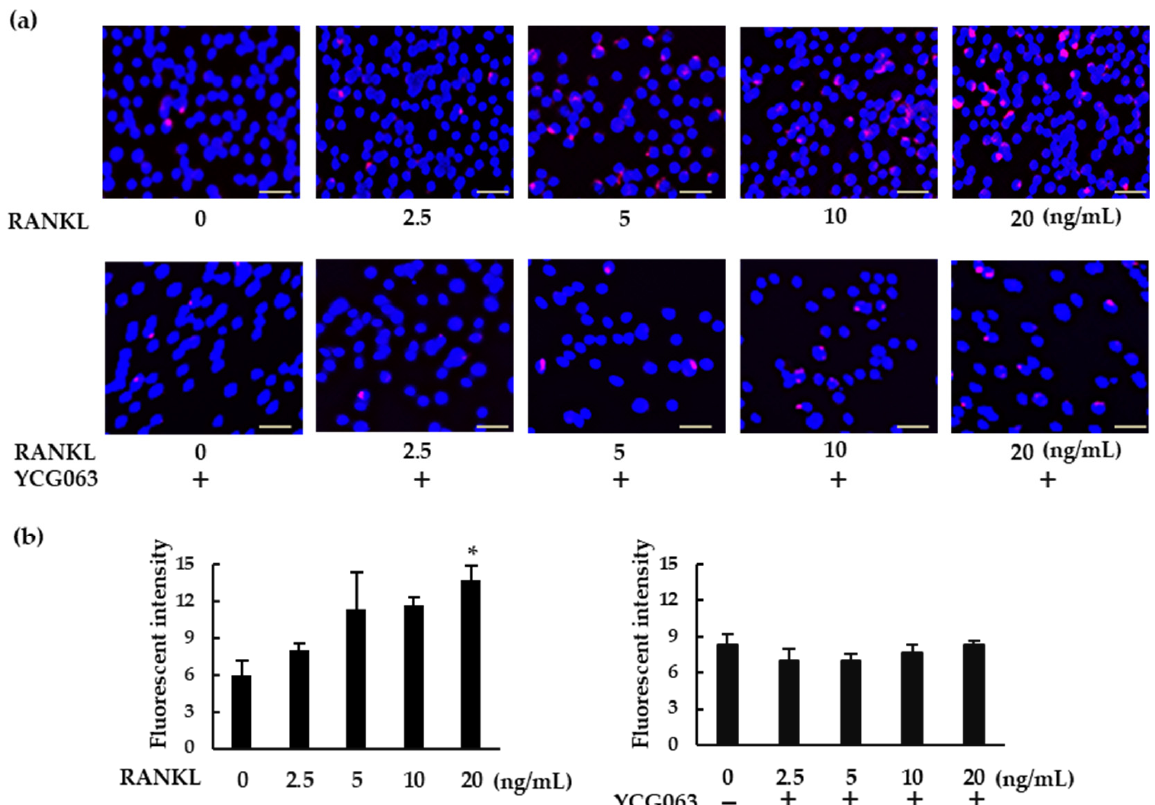
Figure 5. RANKL induces intracellular ROS production in BMMs. ( a ) BMMs were seeded in a 96-well plate and cultured overnight. The cells were then treated with M-CSF (30 ng/mL) and various concentrations of RANKL (0, 2.5, 5, 10, or 20 ng/mL) for 30 min. For the inhibition assays, the cells were pretreated with YCG063 (a ROS inhibitor; 20 µ M) in the presence of M-CSF for 1 h. The cells were then stained with a commercial ROS detection kit (red). Hoechst 33342 (blue) was used for counterstaining. ROS-expressing cells were detected using a fluorescence microscope (BZ-X800). ( b ) Fluorescent intensity was measured using a microplate reader. Scale bars: 150 µ m. Results are expressed as the means ± SE of triplicate assays and the images are representative of three independent experiments. * p < 0.05 compared with the control.